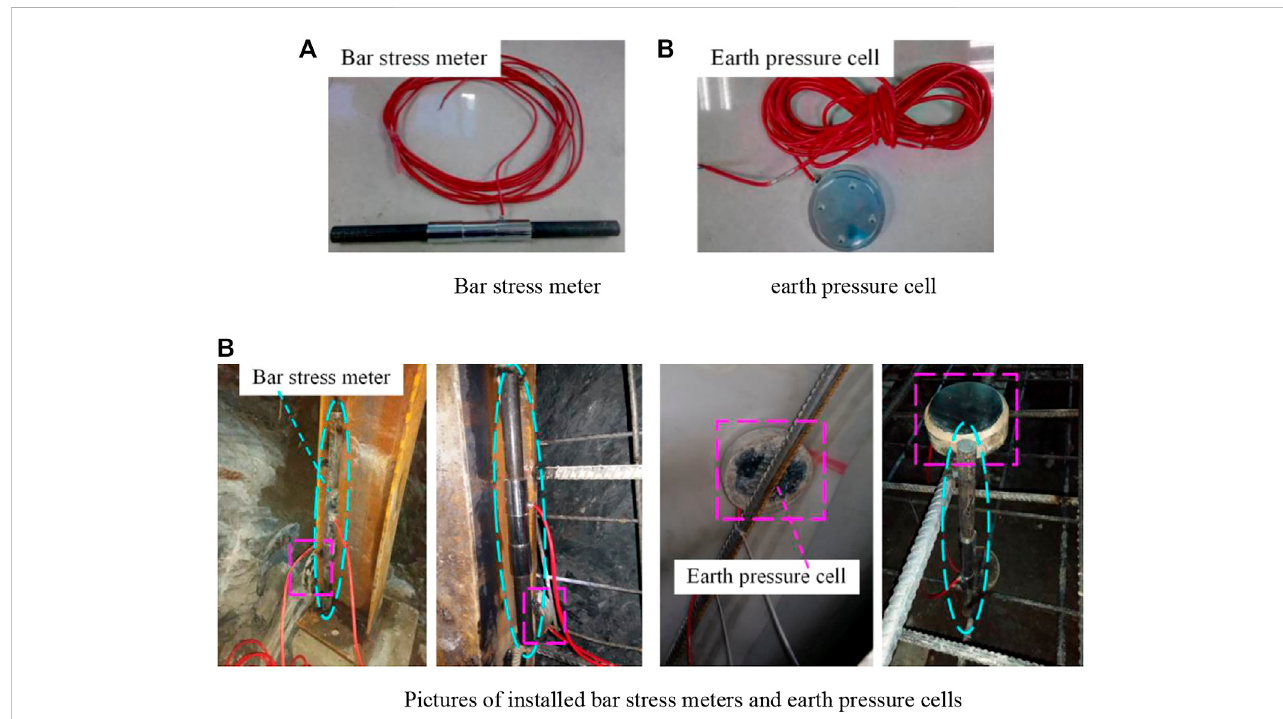
FIGURE 6 Measuringelementsandon-siteinstallation. (A) BarstressmeterandEarthpressurecell. (B) PicturesofinstalledbarstressmetersandEarthpressurecells.